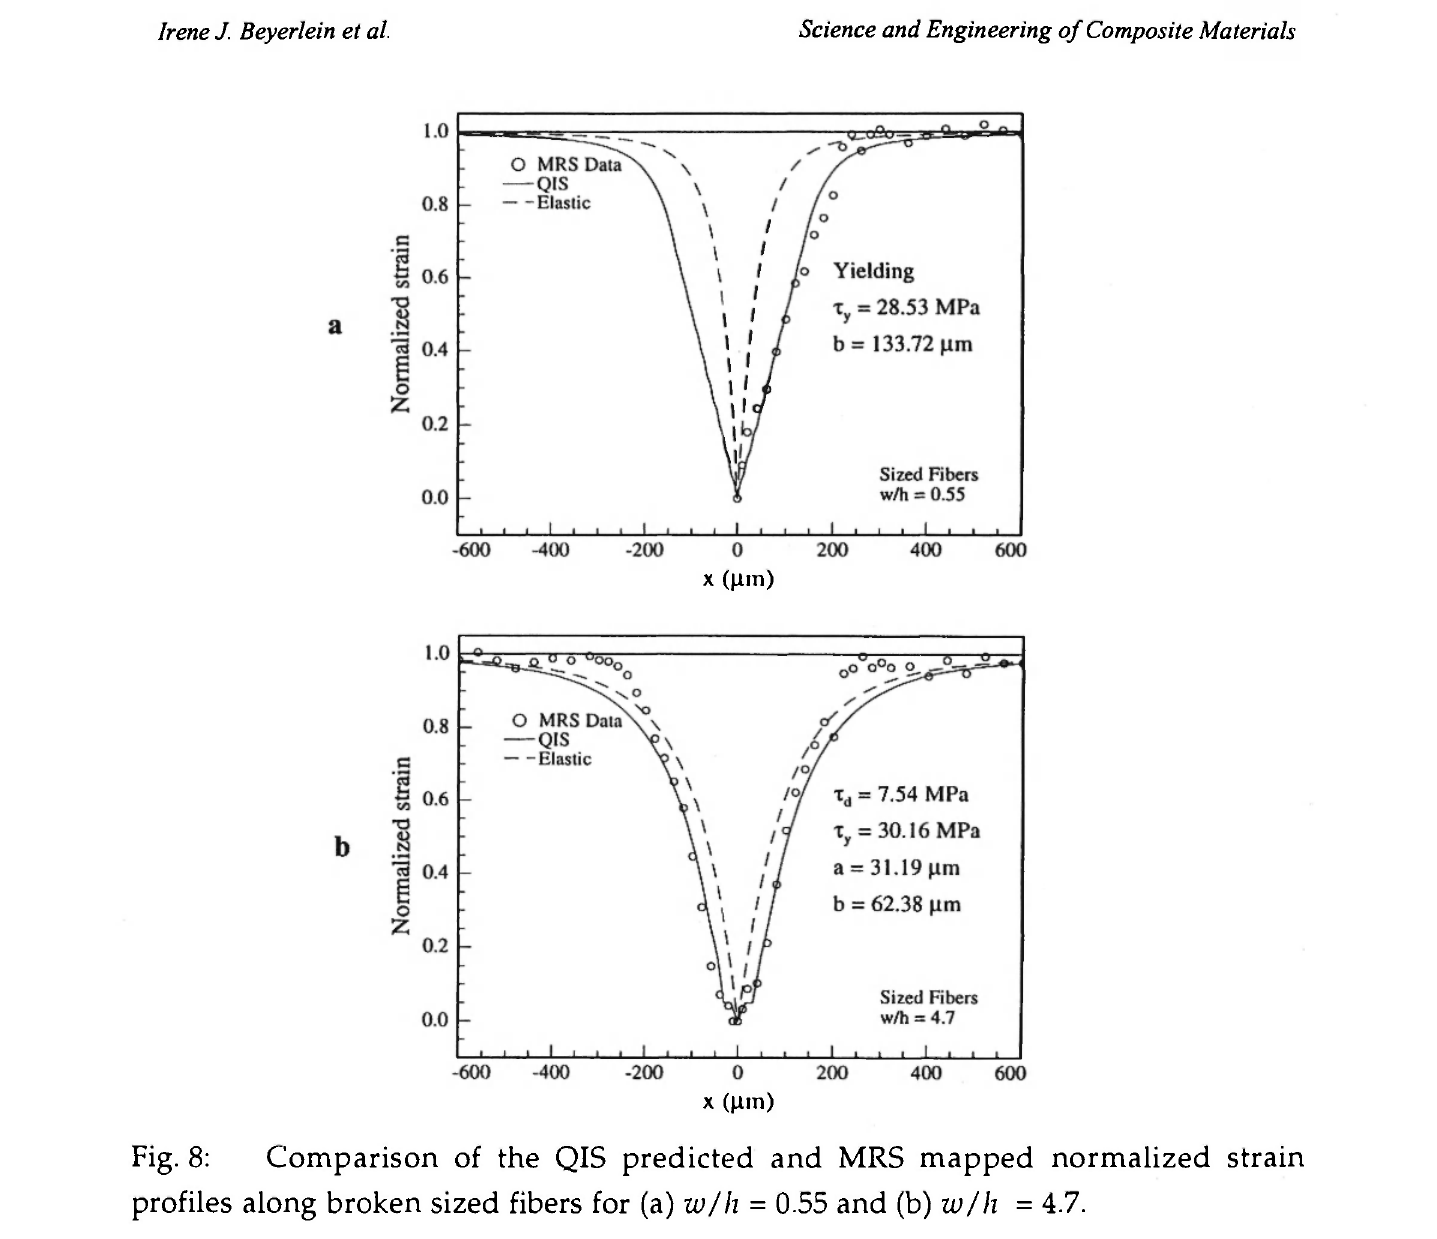
Fig. 8: Comparison of the QIS predicted and MRS mapped normalized strain profiles along broken sized fibers for (a) w/h = 0.55 and (b) w/h = 4.7. strain along fibers containing one break mapped by MRS and predicted by QIS. As indicated, each sample varies in the applied far field strain e, normalized interfiber spacing w/h, and interface